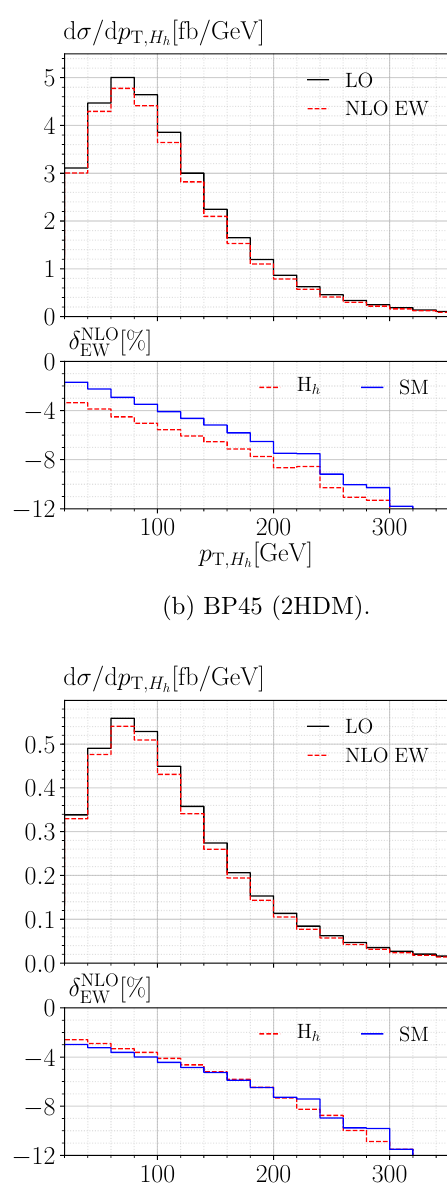
T ;H h for heavy Higgs